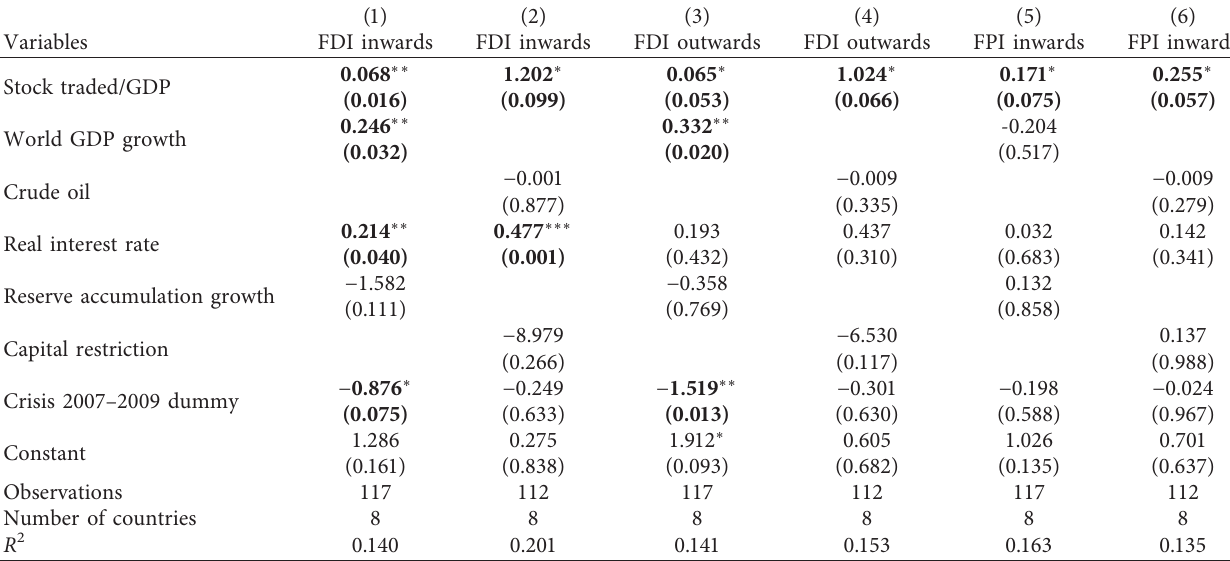
Table 7: Regression analysis in eight developed